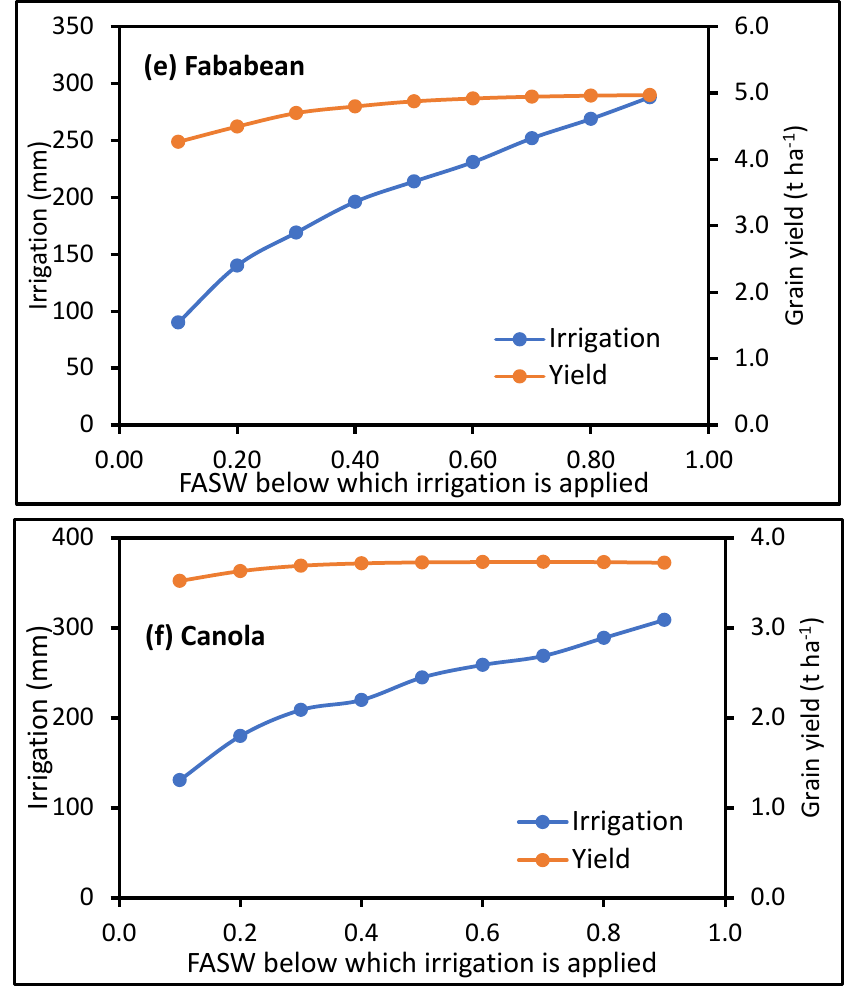
Figure 4. The amount of irrigation and corresponding grain yield of summer and winter crops for different soil water deficit levels in the Riverina region, NSW, Australia.